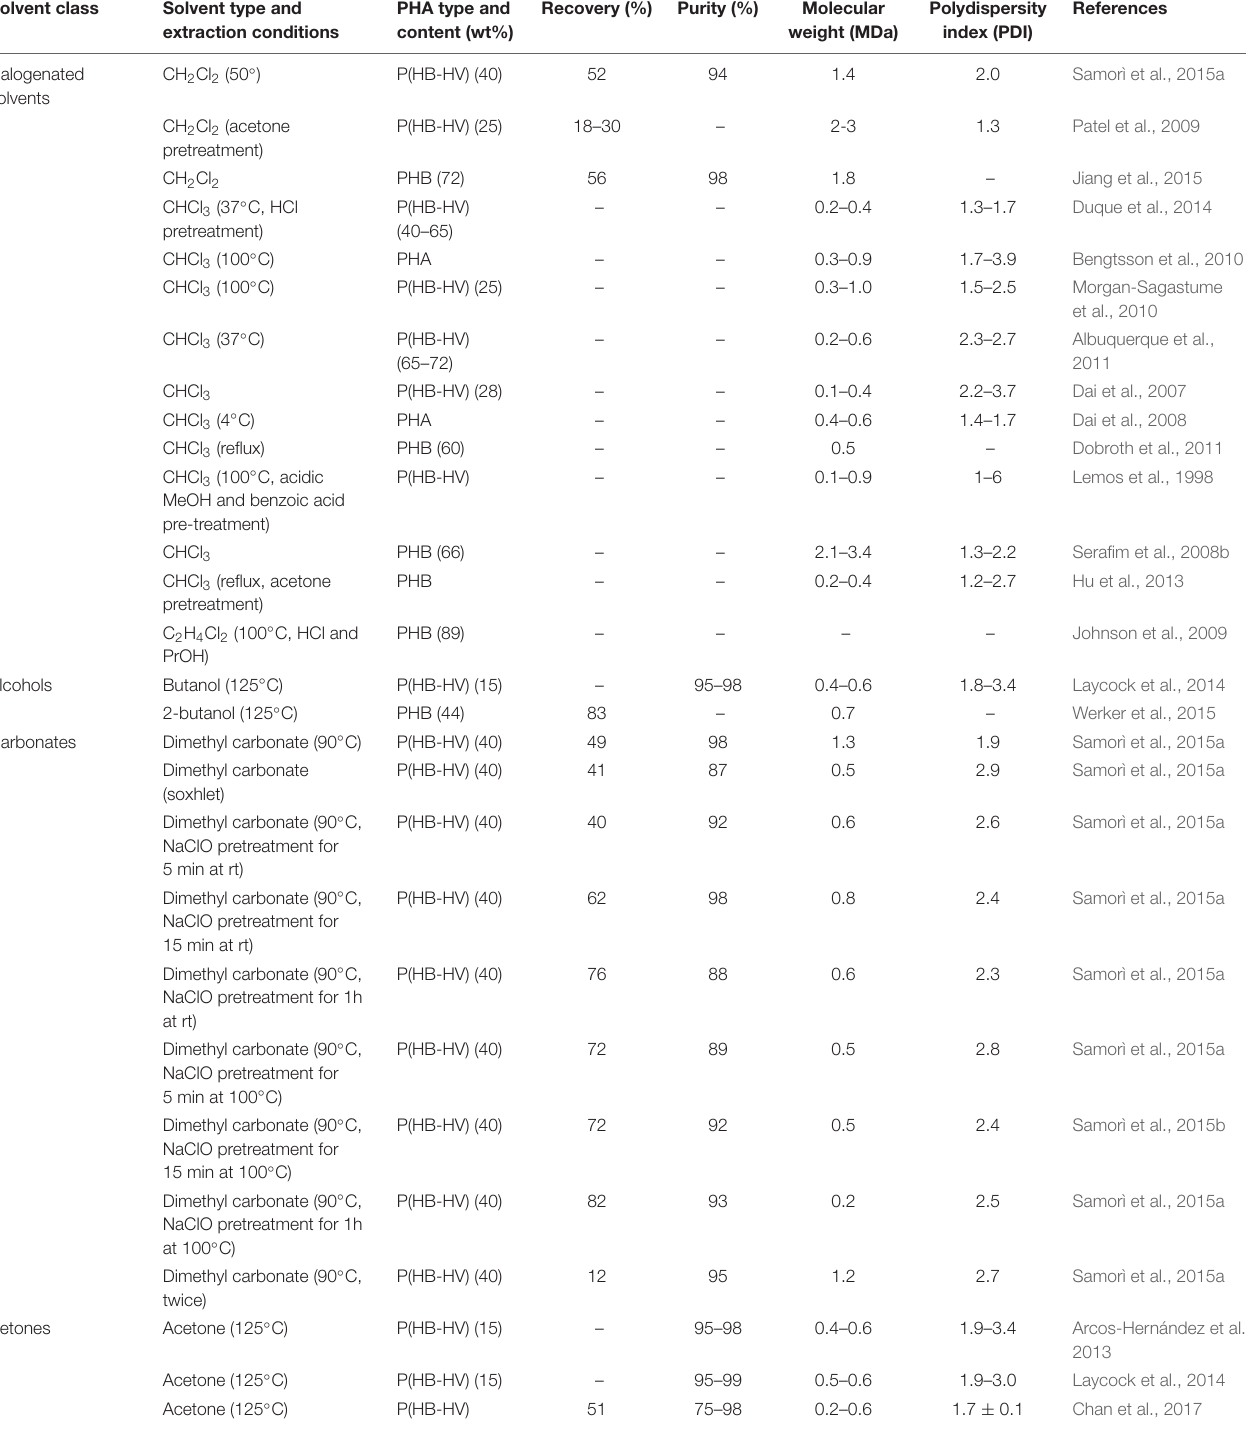
TABLE 4 | PHAs extraction from mixed microbial cultures with